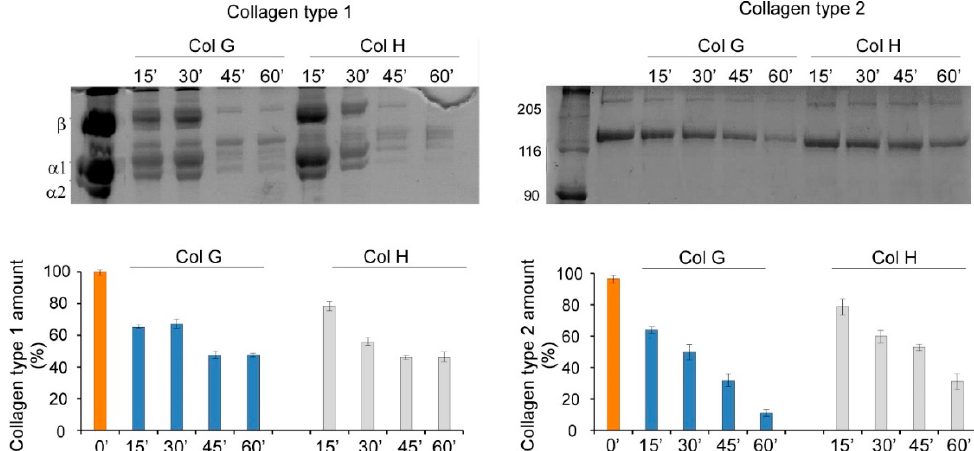
Figure 2. SDS PAGE and densitometric analyses of collagen type I (left panel) and type II (right panel) digested by ColG and ColH. Digestion was performed at different sampling times, i.e., 0’, 15’, 30’, 45’, and 60’.